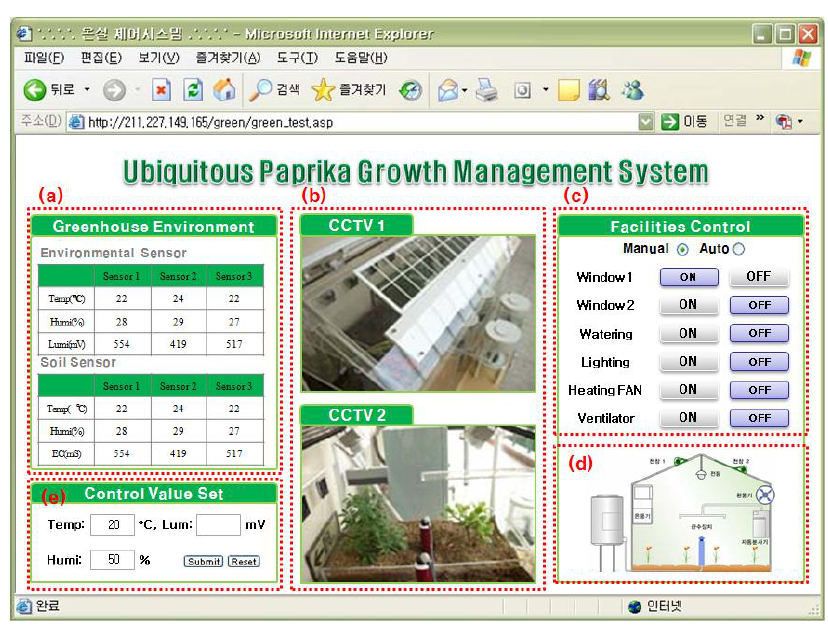
Figure 10. Test-bed GUI.